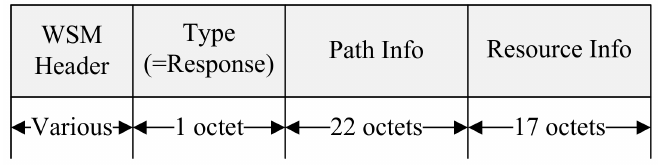
Figure 9. The format of the proposed Coop Response message.